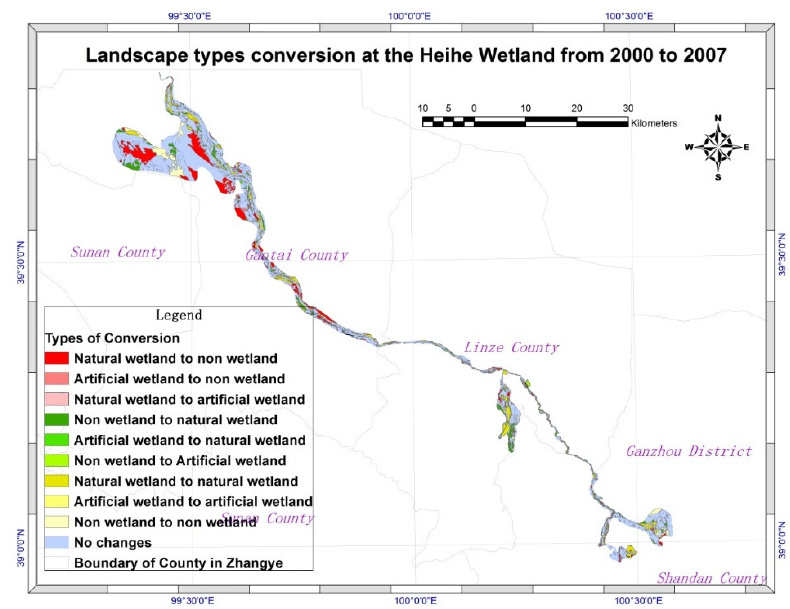
Figure 4. Transition of landscape types during 2000–2007 in the Heihe wetlands. The legend in the